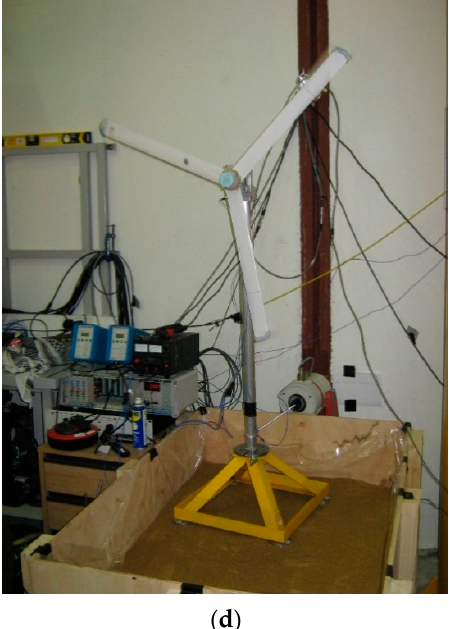
Figure 14. ( a ) “Whole system model with an actuator connected to the model through a rigid link”—Type 2 technique. ( b ) Model setup and instrumentation used for small-scale wind turbine supported on a monopile: (i) photograph and schematic diagram; (ii) Impedance in a rigidly connected actuator [30]. ( c ) Other applications for Type 2 modelling. ( d ) Example application of the Type 2 technique.